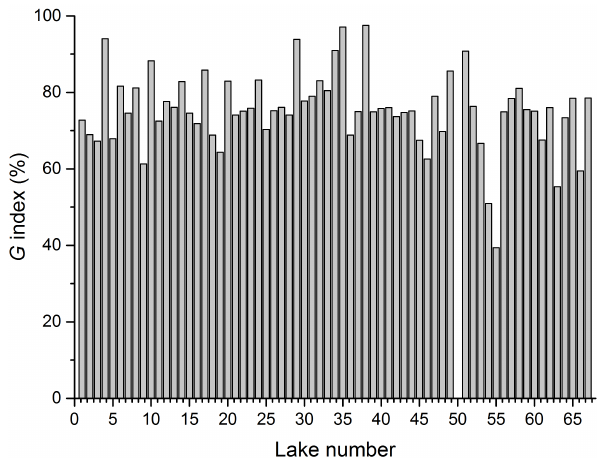
Figure 8. The G index quantifying the groundwater dependency of lakes in the Rokua study area. The index is defined as the percent- age contribution of groundwater inflow to the total inflow of water to the given lake. Shown are the mean G values obtained from in- dependent isotope mass balance calculations based on 2 H and 18 O